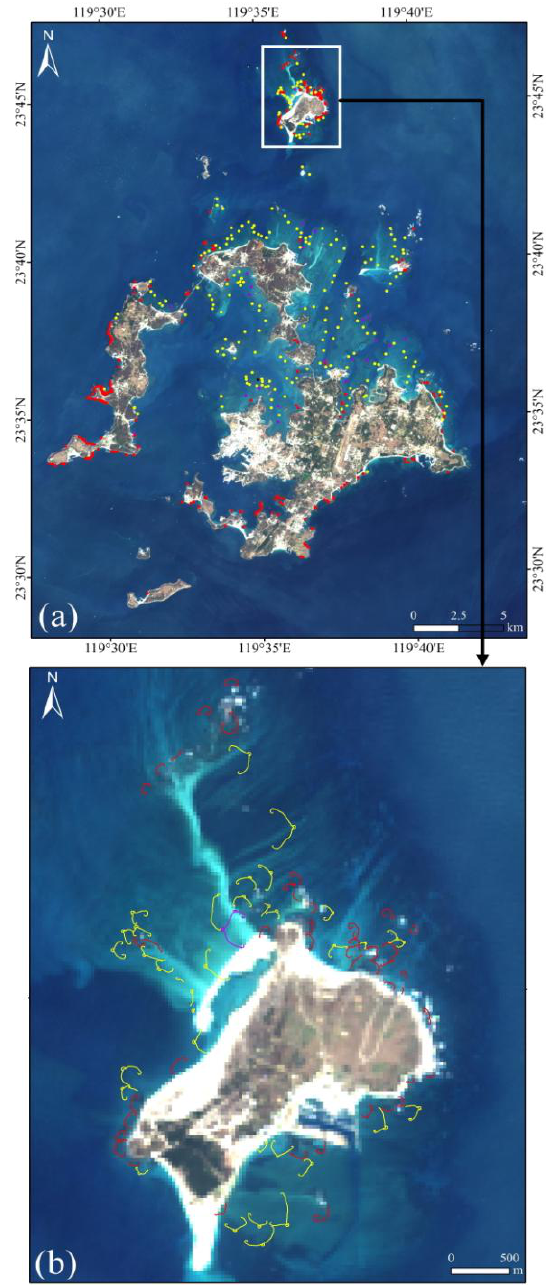
Figure 3. The distribution of STWs on Penghu and Chipei Island (the base map is the Landsat-8 OLI image which can be downloaded from http://www.usgs.gov), red, yellow and violet represent the arched, single-room and double room, respectively.